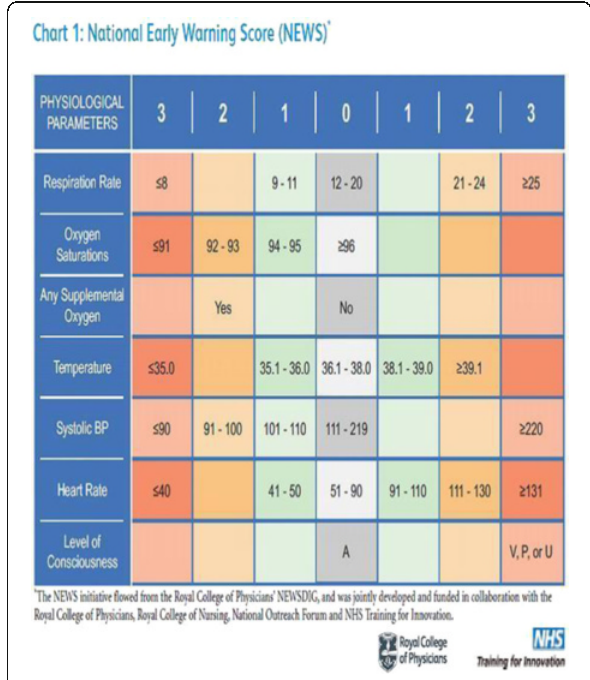
Fig. 117 (abstract A303). Distribution of NEWS in the total IHCA a